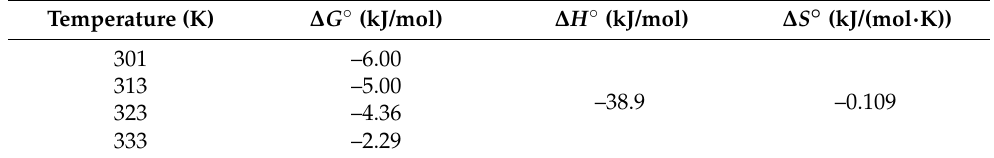
Figure 10. Plot of ln K d against 1/ T for estimation of thermodynamic parameters for adsorption of MO onto the DA5 sample (dosage = 0.5 g/L, initial concentration = 20 mg/L, initial pH = 6.9). Table 3. Thermodynamic parameters for MO adsorption on the DA5 sample.